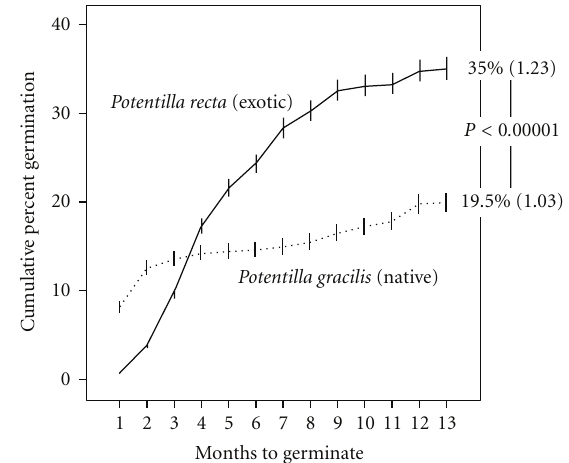
Figure 6: Cumulative percent germination by month for Potentilla gracilis (native) and P. recta (invasive), from seeds collected from plants at Ham and Rice sites, northeastern OR, July 2003–June